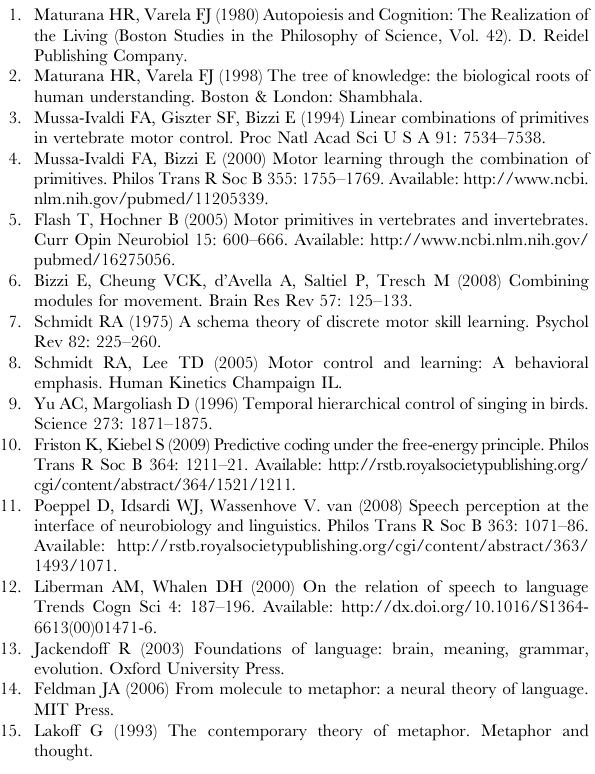
Figure S6 Phase space analysis for s = 0.01 . Figure